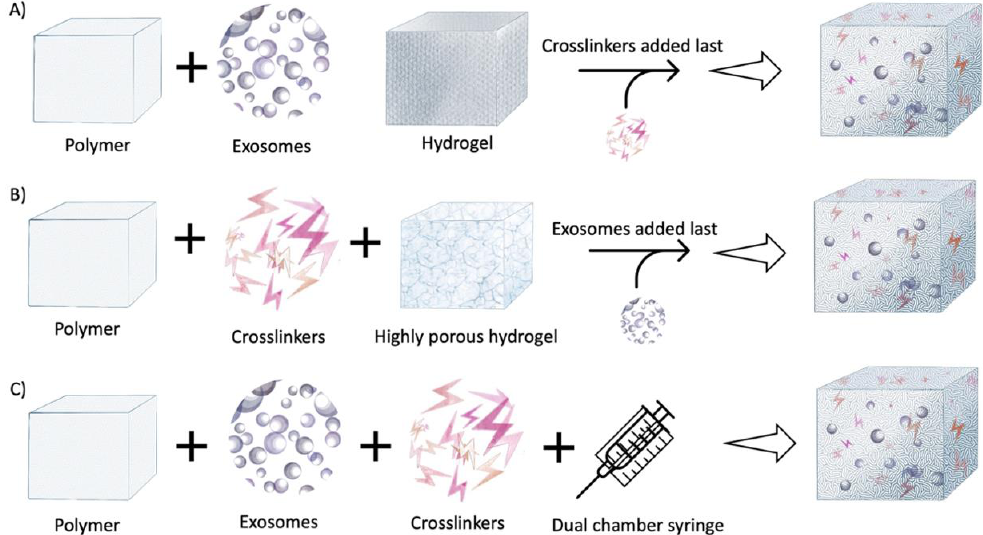
Figure 5. Approaches to encapsulate exosomes in hydrogels: ( A ) Combining the exosomes with polymers followed by addition of crosslinkers to induce gelation. ( B ) Physical incorporation of the hydrogels, or the “breathing” technique. ( C ) Mixing of the exosomes with both the polymers in solution and crosslinkers simultaneously. Adapted from Riau et al. 2019 [14].